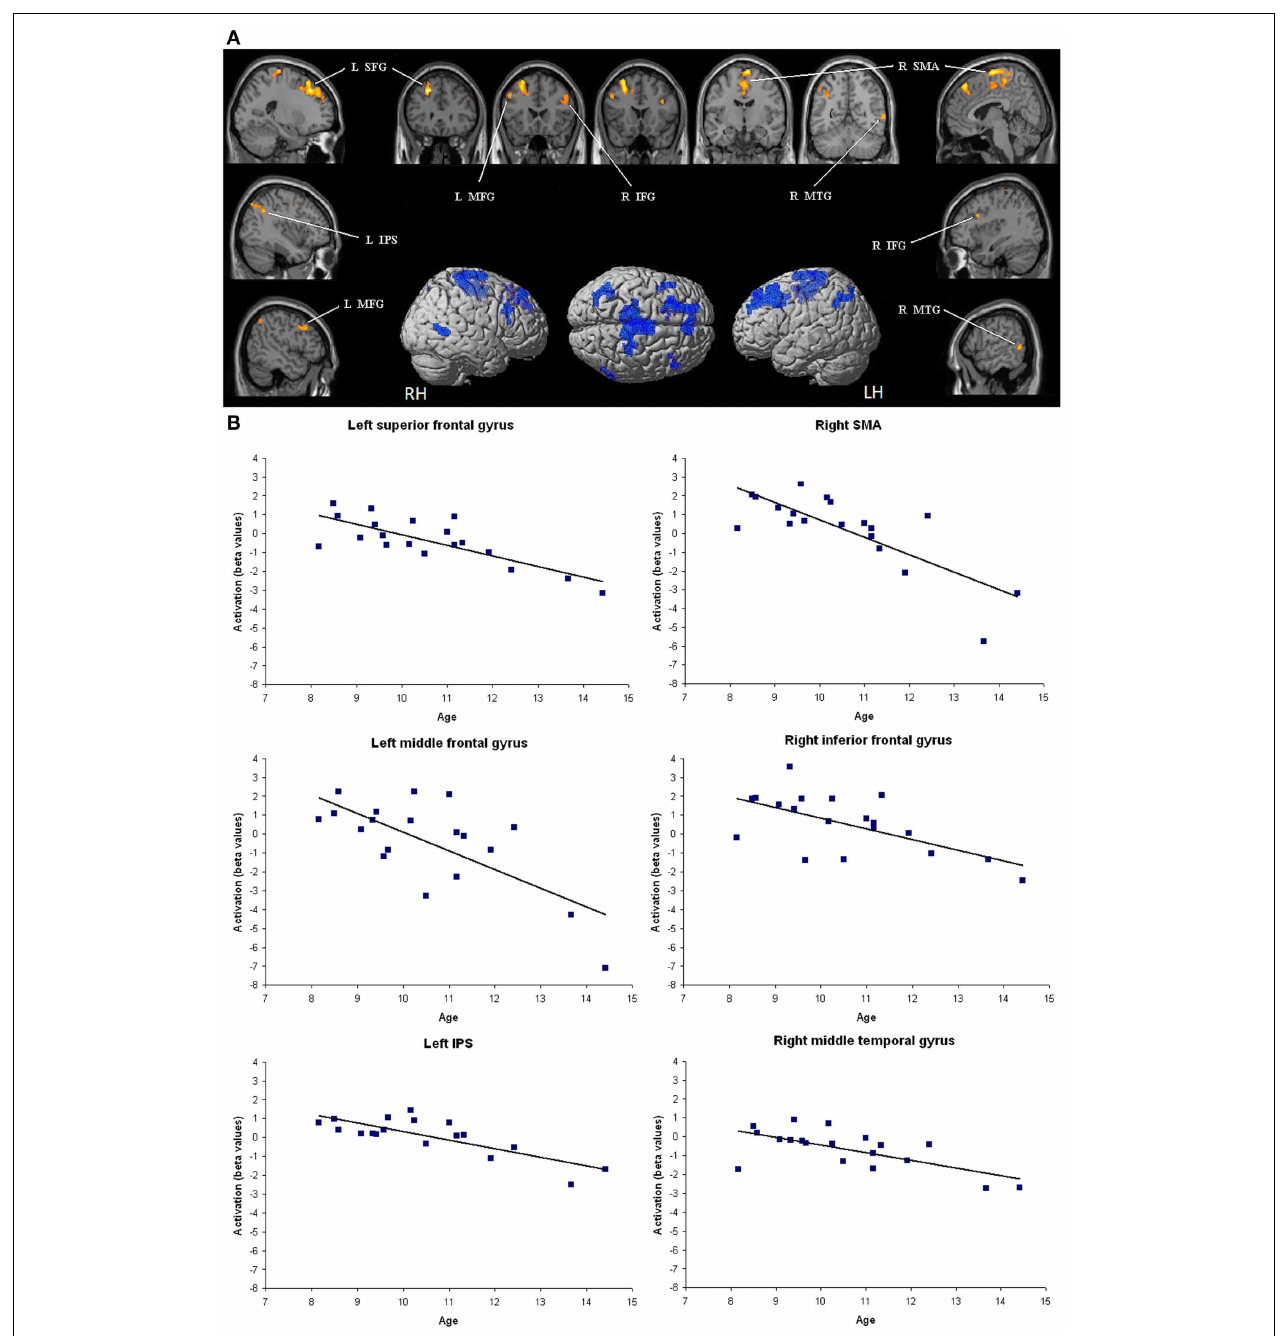
FIGURE 1 | Brain areas that showed significant decreases in activation with age. (A) Brain regions ( P < 0 . 05 corrected for multiple comparisons at the cluster level) are superimposed on sagittal and coronal sections of an individual normalized brain MRI. Surface rendering of significant areas of activation that are negatively correlated with age are superimposed on a